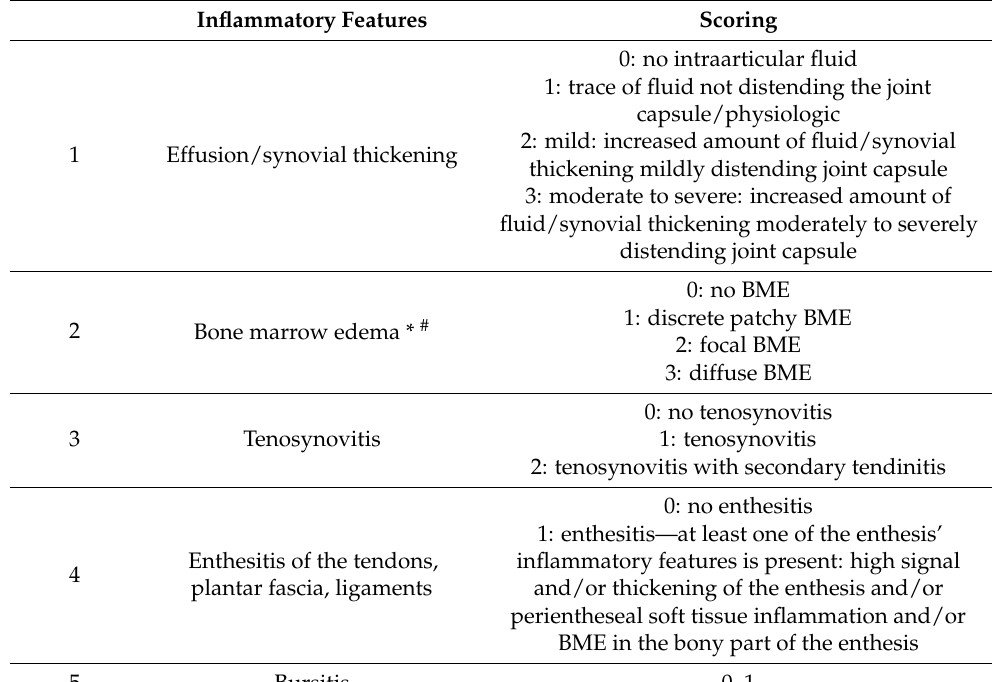
Table 2. MRI scoring system for ankle joint